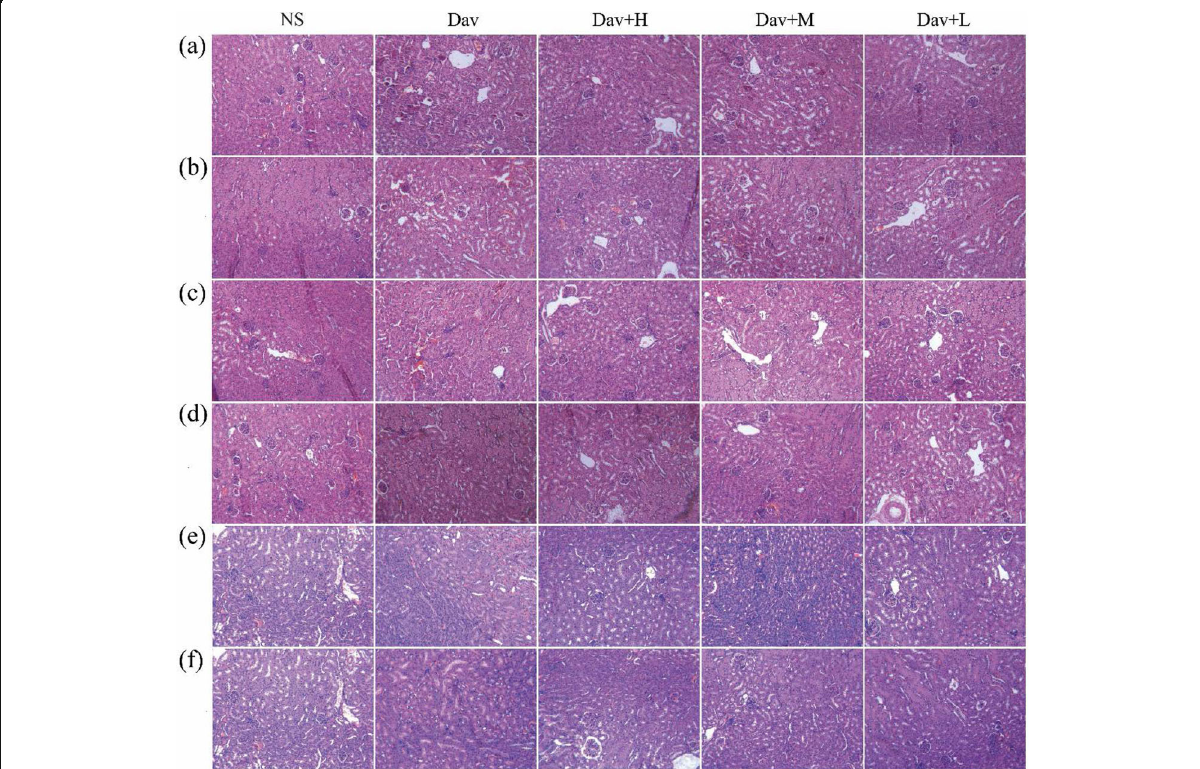
Fig. 12 Effects of Phellodendri Chinensis Cortex Carbonisata-carbon dots (PCCC-CDs) on histopathological changes in kidney tissues in D.acutus venom (Dav)-induced AKI mice. After D.acutus venom challenged, kidney tissues from each experimental group were prepared for histological evaluation. Histological changes of kidney obtained from mice of different groups normal saline (NS), D.acutus venom (Dav, 1 mg/kg) and high (H), medium (M), and low (L) doses of PCCC-CDs + Dav (1 mg/kg) in ( a ) 1 h, ( b ) 3 h, ( c ) 12 h, ( d ) 1 day, ( e ) 2 days, and ( f ) 5